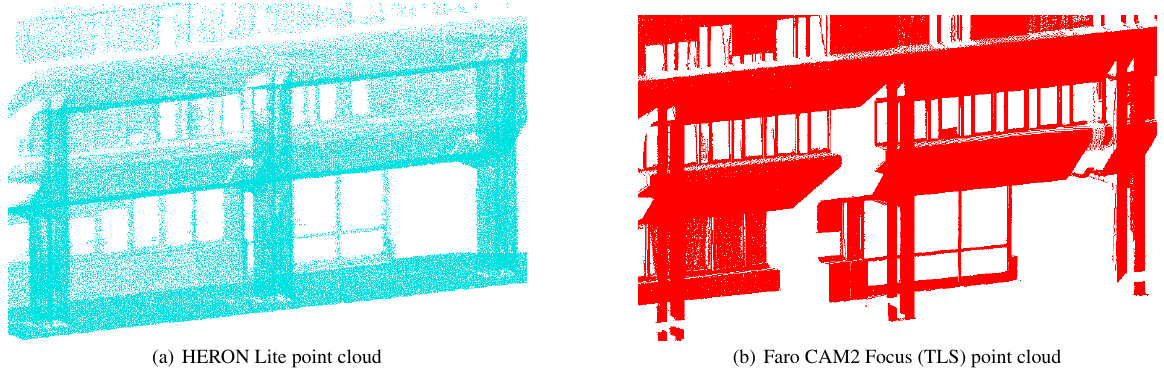
Figure 7. Detail of the facade point clouds. Occluded surfaces produced data gaps in the TLS